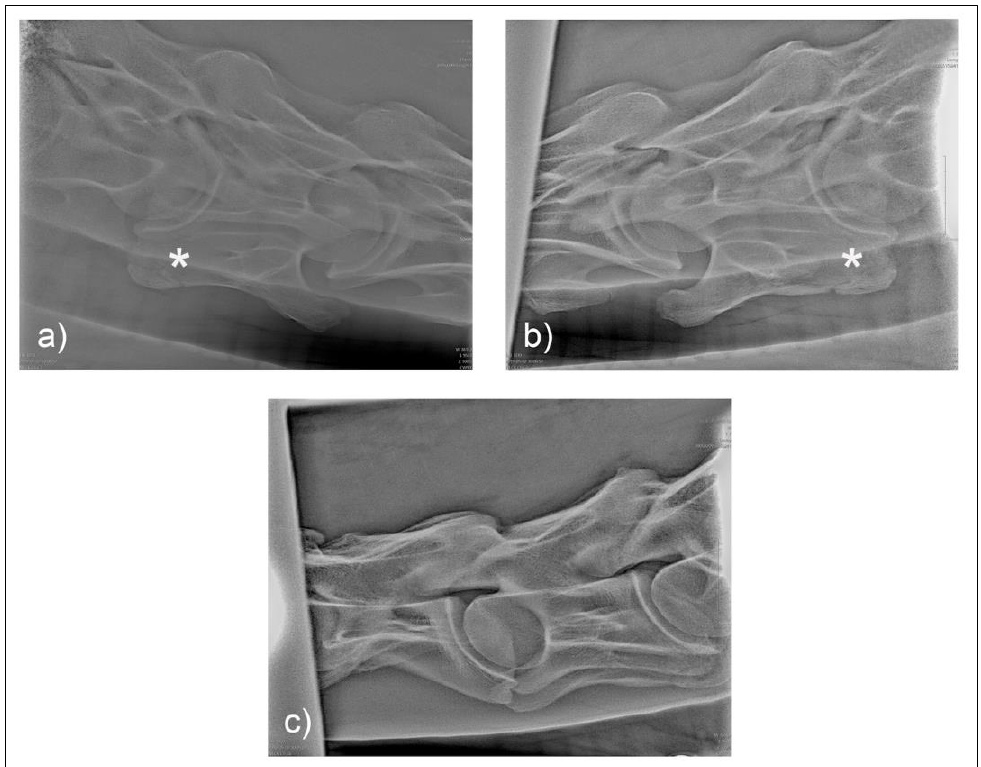
Figure 4. Normal radiographic appearance of C6 with 30° dorsal to ventral oblique right ( a ) and left ( b ). In the laterolateral view ( c ), the head is to the left, and both left and right ventral laminae are visible. Note the incomplete centers of ossification of the ventral laminae (*). (Images have been left in nonstandard orientation for simplicity).